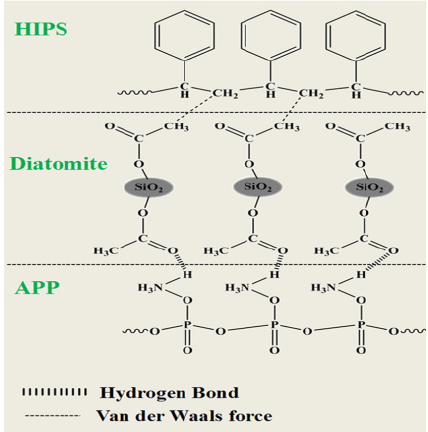
Figure 3. The diagram of IFR/diatoms system and HIPS matrix.